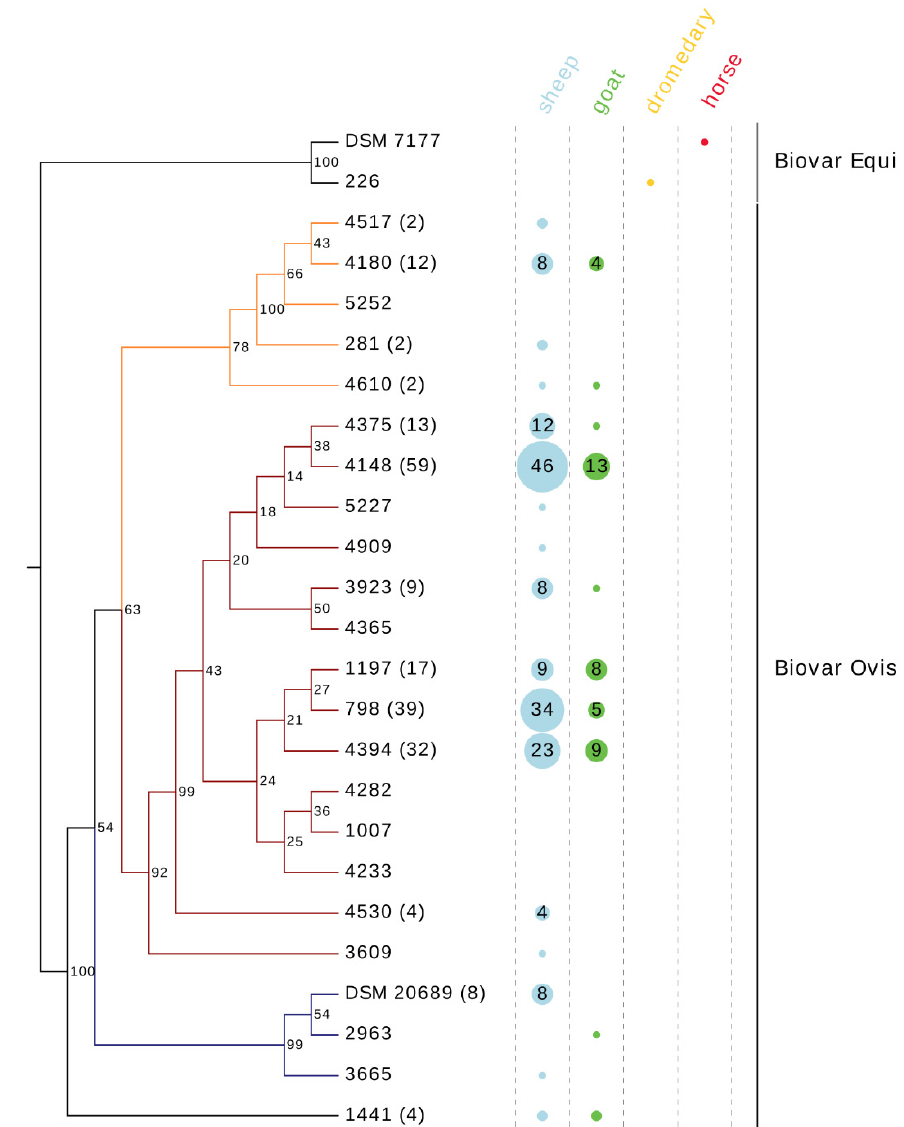
Figure 2. Modified UPGMA tree based on concatenated MLSA sequencing data for 213 C. pseudotuberculosis field isolates and two DSM reference strains. Two field isolates from unknown host origin belonging to the STs “4394” and “798” were excluded. The UPGMA tree was calculated using CLC Genomics Workbench with 1.000 bootstrap values. The tree was modified using EvolView v2. Branch colors indicate phylogenetic groups: orange—group 1; red—group 2, blue—group 3. The strain identifiers at the end of the branches indicate a representative isolate for each ST, in brackets the number of isolates belonging to the ST is given. ST “DSM 20689” corresponds to ST “4354” in the goeBURST diagrams. The columns show the host animals from which the isolates were isolated.